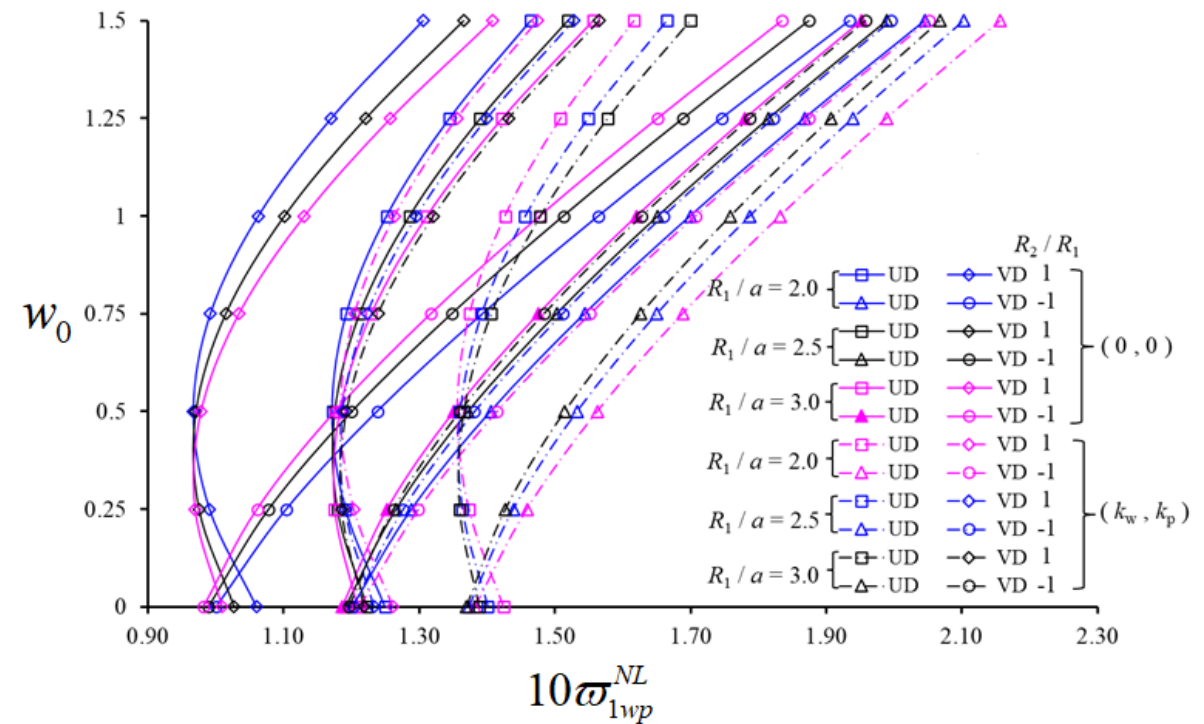
Figure 3. Variation in NLFVF for shallow spherical and hypar shells with UD- and VD-patterned CNTs on a PF versus w 0 , with different geometrical ratios R 1 / a